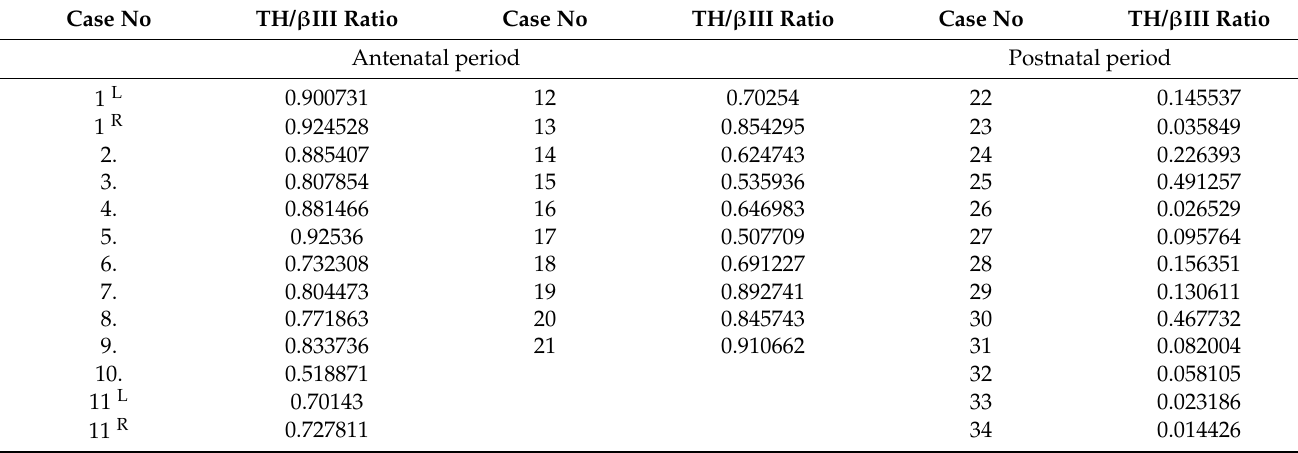
Figure 5. Strong expression of β III-tubulin ( A ) and tyrosine hydroxylase ( B ) in the carotid body of the 19 – 20 GW fetus. Strong expression of β III-tubulin ( C ) and low expression of tyrosine hydroxylase ( D ) in the carotid body of the 78-year-old woman. Nuclei stained with hematoxylin. Bar = 50 μm. Table 3. TH/ β III ratio in the human carotid